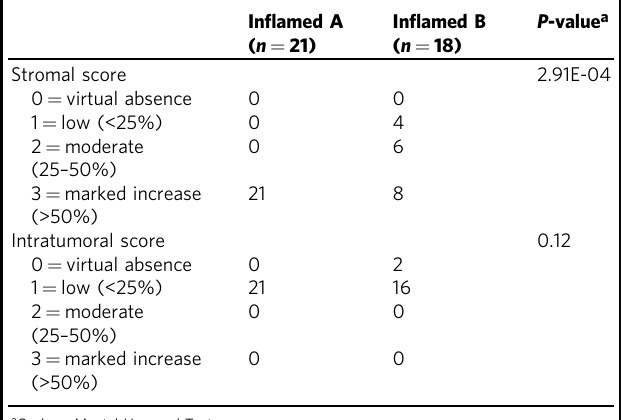
Table 2 CD33 immunohistochemistry